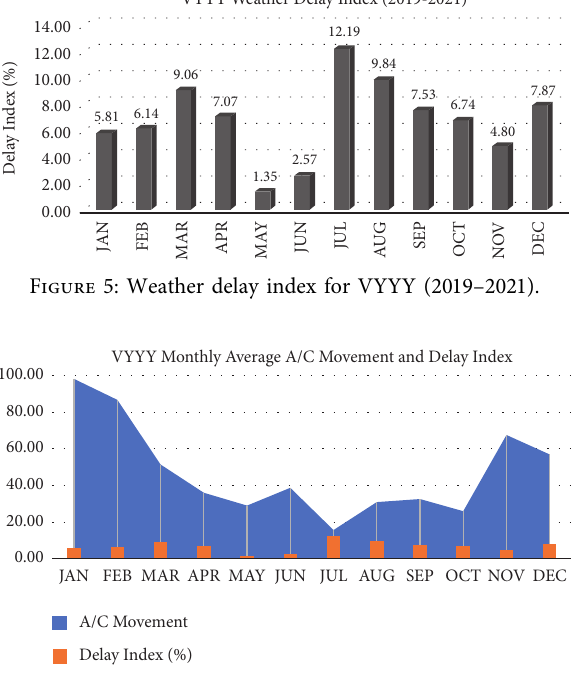
Figure 6: Correlation of monthly aircraft movement and delay